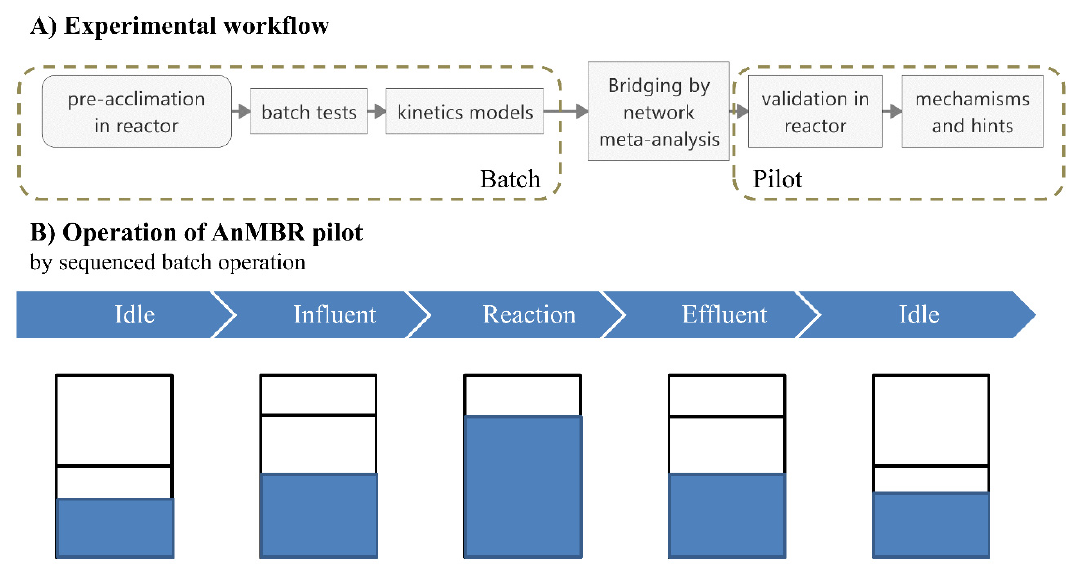
Figure 1. ( A ) Workflow of the prediction. ( B ) Sequenced batch operation of the semicontinuous anaerobic membrane bio- reactor.